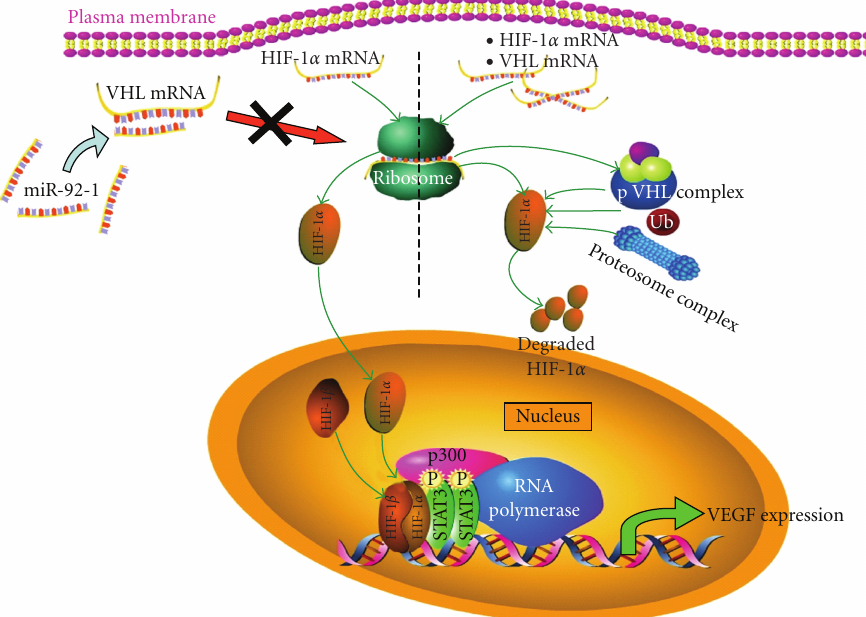
Figure 4: Autocrine production of VEGF in CLL B cells is regulated by miRNA-92-1 inhibition of pVHL production. Expression of high levels of VEGF by tumor cells is critical to promote and sustain the angiogenesis needed for cancer progression. Under normal oxygen tension, the HIF-1 α subunit of the transcription factor, HIF-1, is constitutively produced and rapidly degraded by pVHL-induced proteasomal degradation, which prevents transcription of the VEGF gene. In solid tumors, HIF-1-induced VEGF expression occurs when tumor growth exceeds the dimensions where existing blood vessels can feed the tumor and carry away waste products. The resulting hypoxia leads to stabilization of HIF-1 α and activation of the HIF-1 heterodimer resulting in high VEGF production by tumor cells. Although solid tumors do not develop in hematological malignancies, angiogenesis is an important process of disease progression. CLL B cells constitutively express high levels of VEGF and VEGFRs leading to autocrine signaling and increased resistance to apoptosis. Recently, Ghosh et al. [273] discovered that HIF-1 is stabilized in CLL B cells due to low levels of pVHL as a result of miR-92-1 overexpression and subsequent repression of translation of the VHL transcript. Therefore, HIF-1 accumulates and translocates to the nucleus where it forms an active complex with the transcriptional coactivator p300 and phosphorylated Stat3 and, together with the basal transcription machinery, transactivates the VEGF promoter. PPAR γ agonists could potentially inhibit overexpression of VEGF by inhibiting Stat3 signaling in CLL B cells. The schematic in this figure was adapted from